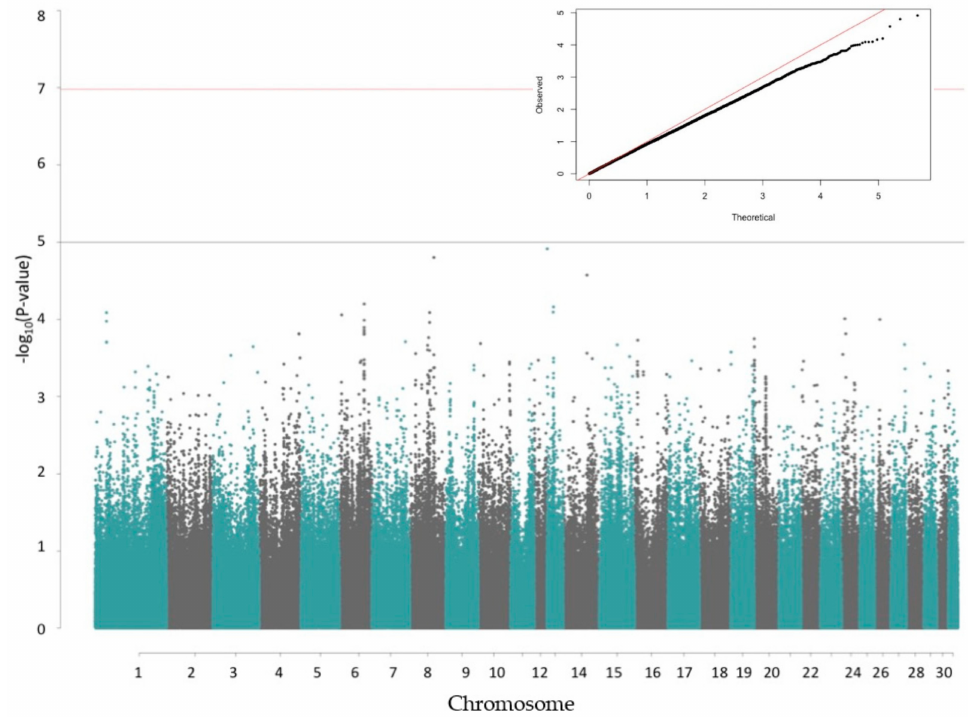
Figure A3. Manhattan plot with position on the genome on the x-axis and significance ( − log10( p -values)) on the y-axis in the Belgian Warmblood horse population for IBH status (case-control) using a structured association analysis in GenABEL package in R [35,38]. The red line represents the Bonferonni corrected significance threshold and the grey line a nominal significance threshold ( p -value = 1 × 10 − 5 ). Q-Q plot indicating that inflation factor lambda was < 1, requiring no further